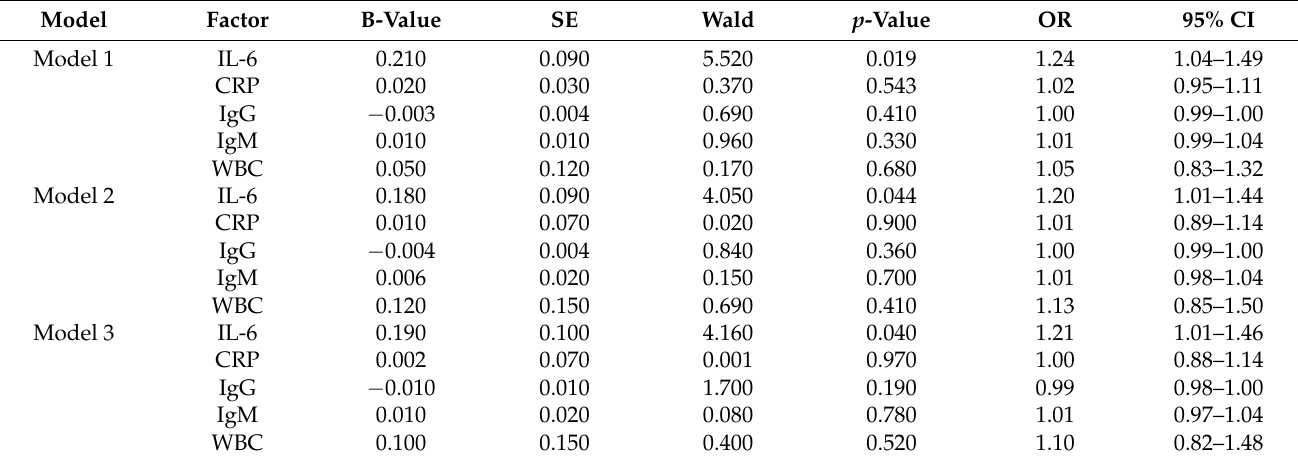
Table 2. Multivariate logistic regression analysis of serum indicators and DPOAE results in the different groups.